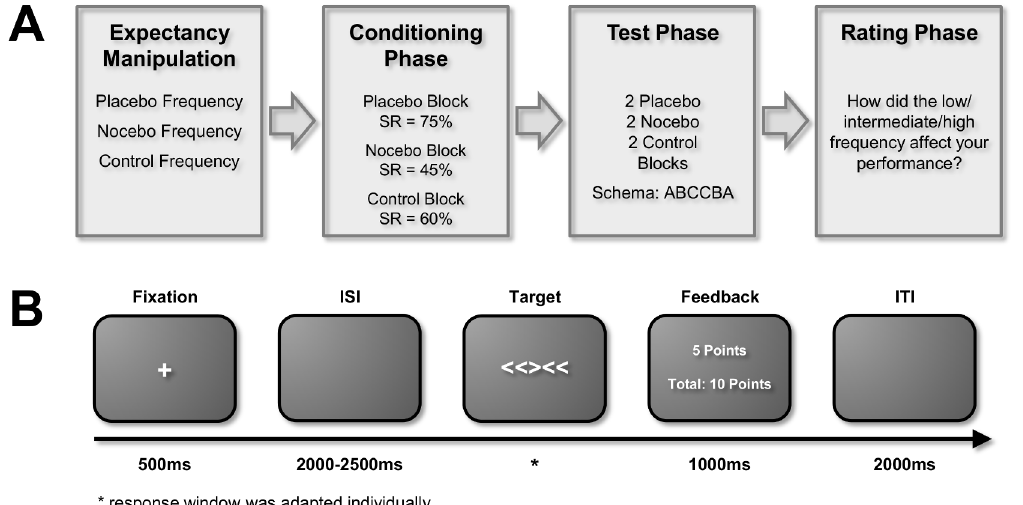
Fig 1. A. Study design. The study started with an expectancy manipulation: Participants were first informed about the effects of “ frequency stimulation ” and heard three different tone frequencies allegedly designed to either improve, impair, or not affect cognitive functioning (placebo, nocebo, and control frequencies). They then underwent a conditioning phase with fixed success rates to strengthen their expectations, followed by the actual test phase without any additional manipulations pertaining to success rates. In the subsequent rating phase, participants evaluated how the frequencies affected their performance. B. Trial procedure of the Flanker task . This trial procedure was used during conditioning and to assess cognitive performance during test. Participants first saw a fixation cross on the screen followed by a variable inter-stimulus interval (ISI). Then the actual target appeared; participants were asked to respond with a left or right arrow key press when the middle arrowhead pointed to the left or right, respectively. The response window for this task was adapted individually. If participants responded correctly and in time, they gained 5 points per trial, if not they didn ’ t gain any points; this information was presented to them together with the total number of points they had gained during the respective block.